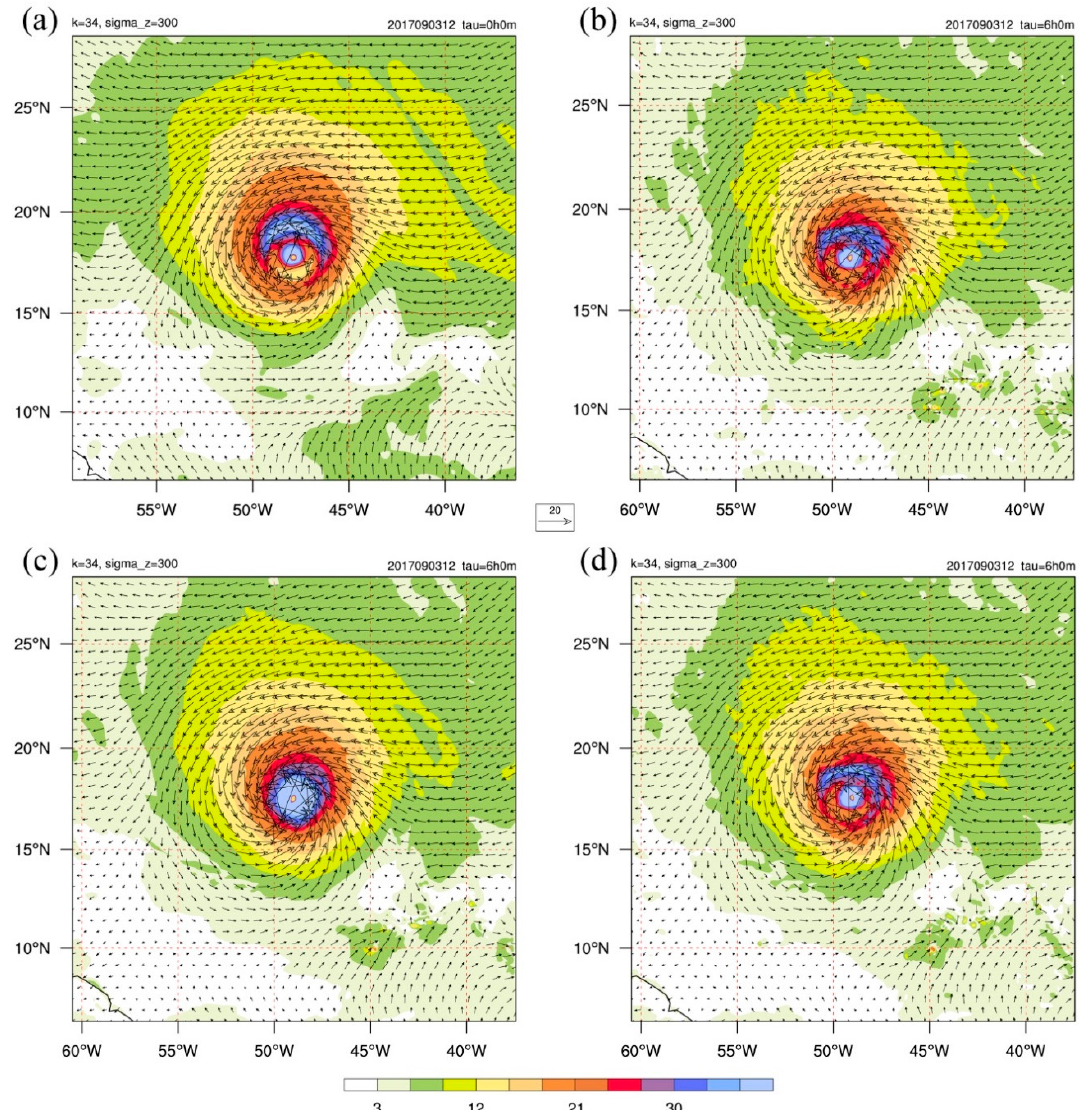
Figure 9. Domain 3 z = 300 m wind vectors (m s − 1 ; color bar at bottom and 20 m s − 1 length indicated by arrow in middle) starting from cold-start COAMPS-TC wind vectors at 12 UTC 3 September in panel ( a ) and then the 15 min AMV and hourly AMV FCDI analyses after 6 h (18 UTC 3 September) in panels ( b ) and ( d ). The COAMPS-TC forecast from initial conditions in panel ( a ) after 6 h in panel ( c ).